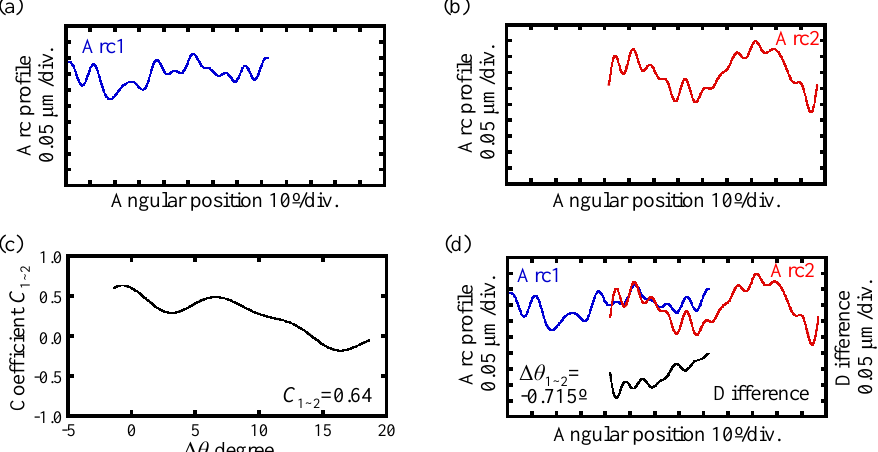
Figure 7. The stitching of the Arc2 with respect to Arc1 by employing all data in the overlapped region: ( a ) Arc1; ( b ) Arc2; ( c ) Variation in the cross-correlation coefficient C 1~2 due to the change in ∆ θ ; ( d ) The stitched Arc1 and Arc2 at ∆ θ = ∆ θ 1~2 .